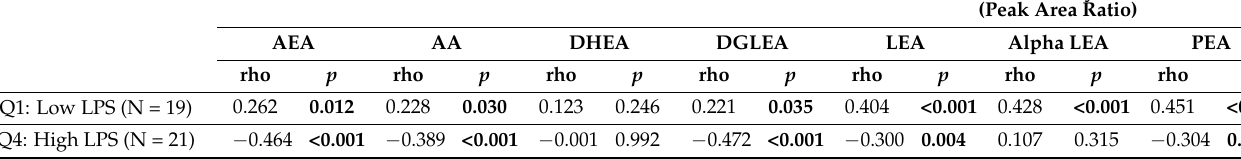
Correlation analyses were performed adjusting for body mass index. Spearman’s correlations coefficient (rho) and p -values ( p ) obtained from univariate Spearman correlation analyses are provided. The bold indicates p -values < 0.05. Alpha LEA: alpha-Linolenoyl ethanolamide; AA: arachidonic acid; AEA: anandamide; DGLEA: dihomo-gamma-linolenoyl